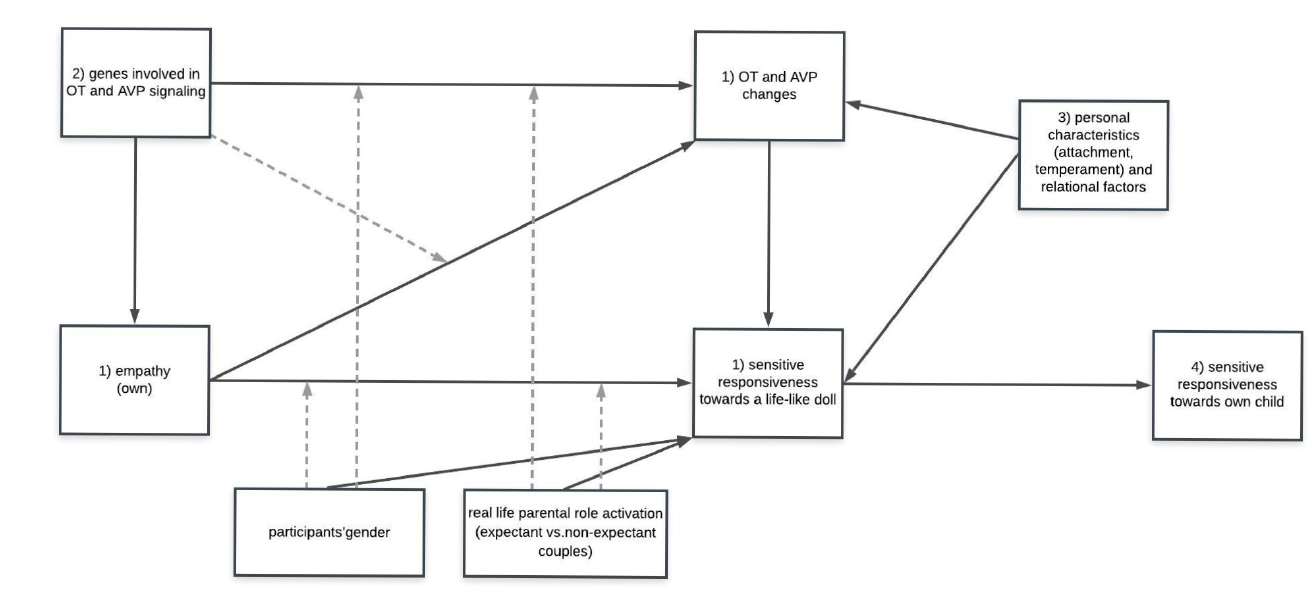
Figure 1. Overview of the most important predictors and outcomes, moderators and mediators. The numbers of the variables refer to the different aims of the couple and the family